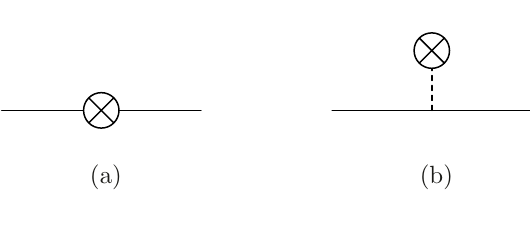
Figure 6. Counterterms on fermion